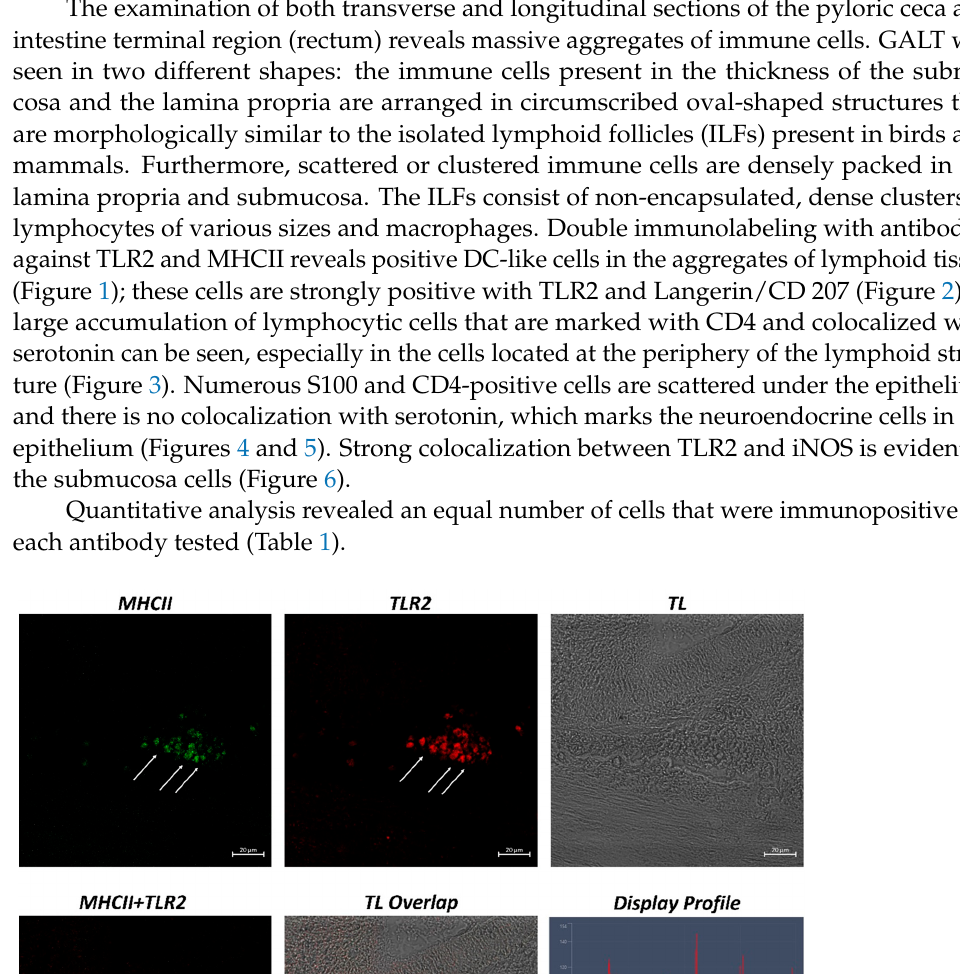
Figure 2. Section of the H. niloticus gut (immunofluorescence 20x, scale bar 20 μ m). DC-like cells that are immunoreactive for Langerin and TLR2, organized in clusters, can be seen (arrows). Some immune cells are positive exclusively for TLR2 (see the arrowhead). The “Display profile” function highlights the colocalization. TL = transmitted light.